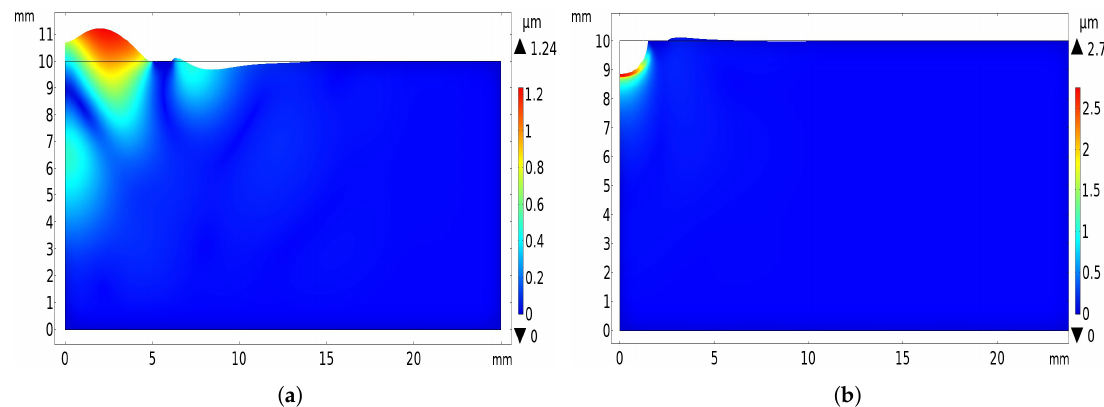
Figure 17. Surface plot of the displacement amplitude z -component in the connected pipette boundary condition; ( a ) pipette radius 5.25 mm; ( b ) pipette radius 1.25